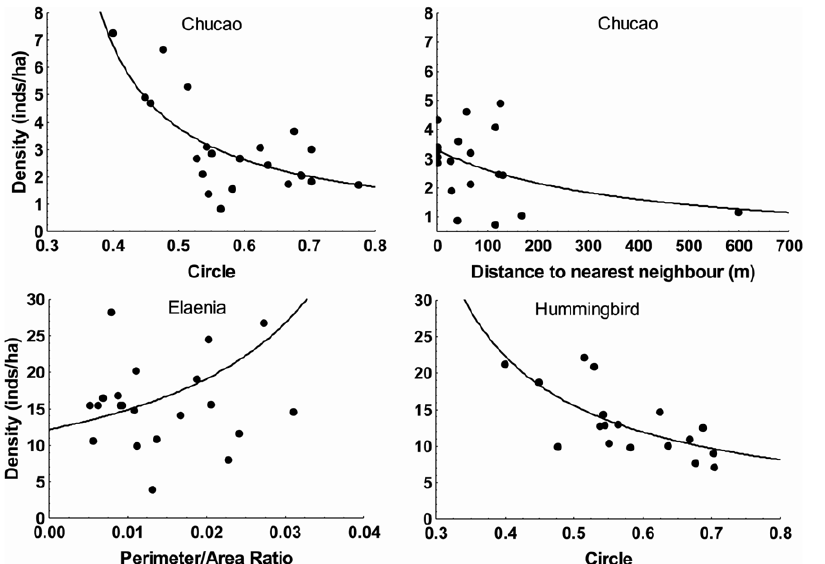
Figure 2. Partial residual plots showing the effects of patch characteristics on species densities (birds/ha). Effect of patch shape (CIRCLE and P/A Ratio) and connectivity (distance to the nearest neighbor) on chucao density (upper two panels), elaenia (lower left panel) and hummingbird (lower right panel). Filled circles represent values obtained after adding raw residuals to predicted values for each variable (assuming mean values for the remaining covariates), and then back-transforming the resultant value. Eliminating the apparent outlier for distance to the nearest neighbor did not change the model and hence it was retained (see Methods).